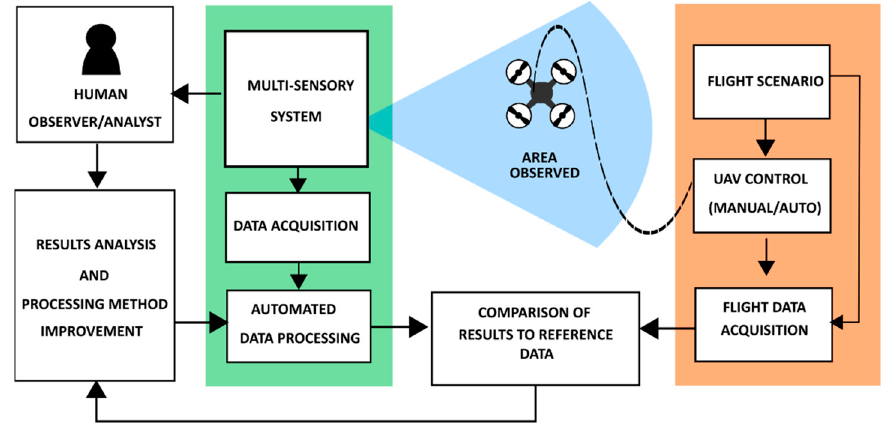
Figure 1. The concept of the system’s tests in realistic conditions.